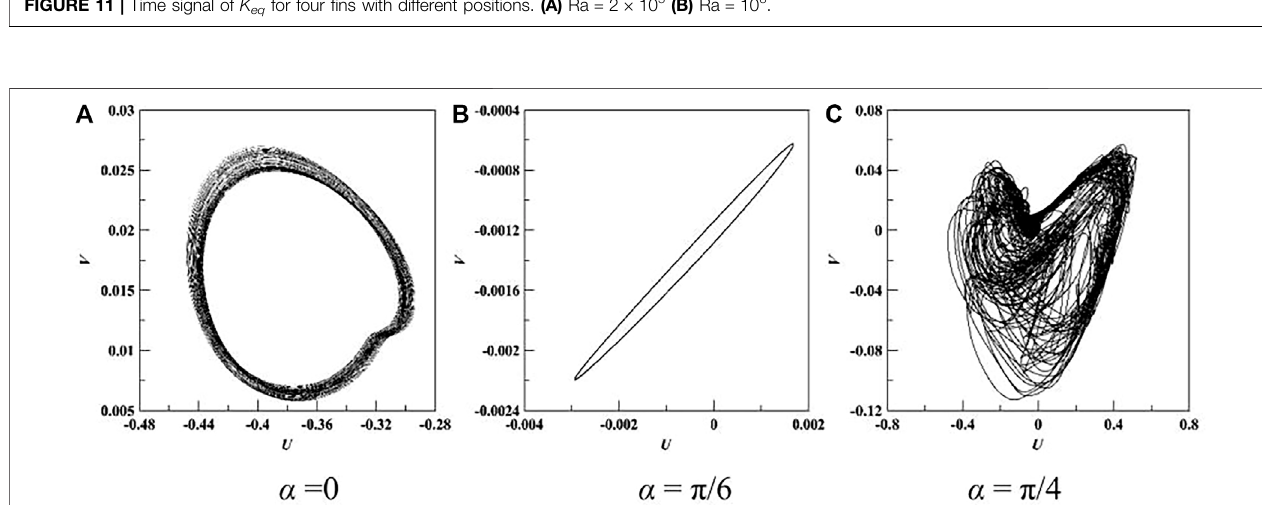
FIGURE 12 | Phase space of velocity at the sample point (20, 5) for n fi n (cid:1) 4, Ra (cid:1) 10 6 . (A) α (cid:1) 0 (B) α (cid:1) π /6 (C) α (cid:1) π /4.